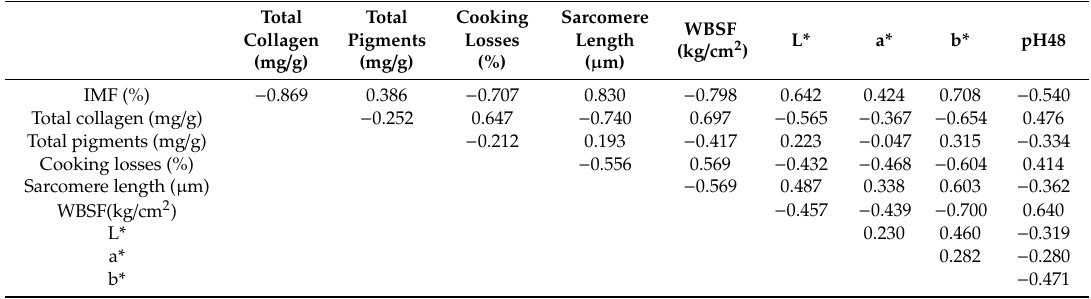
Table 2. Coe ffi cients of correlation between the di ff erent longissimus thoracis et lumborum muscle (LM) physicochemical traits (n = 52) 1 .